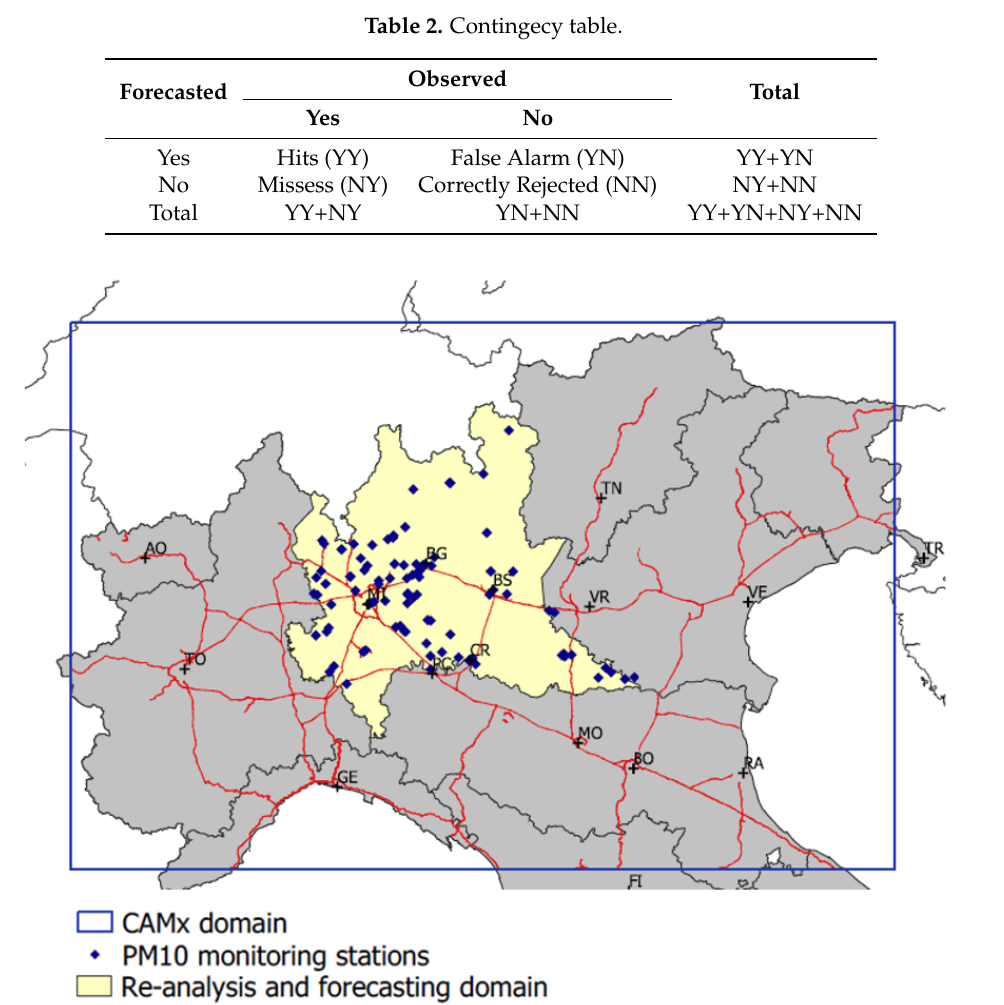
Table 2. Contingecy table.